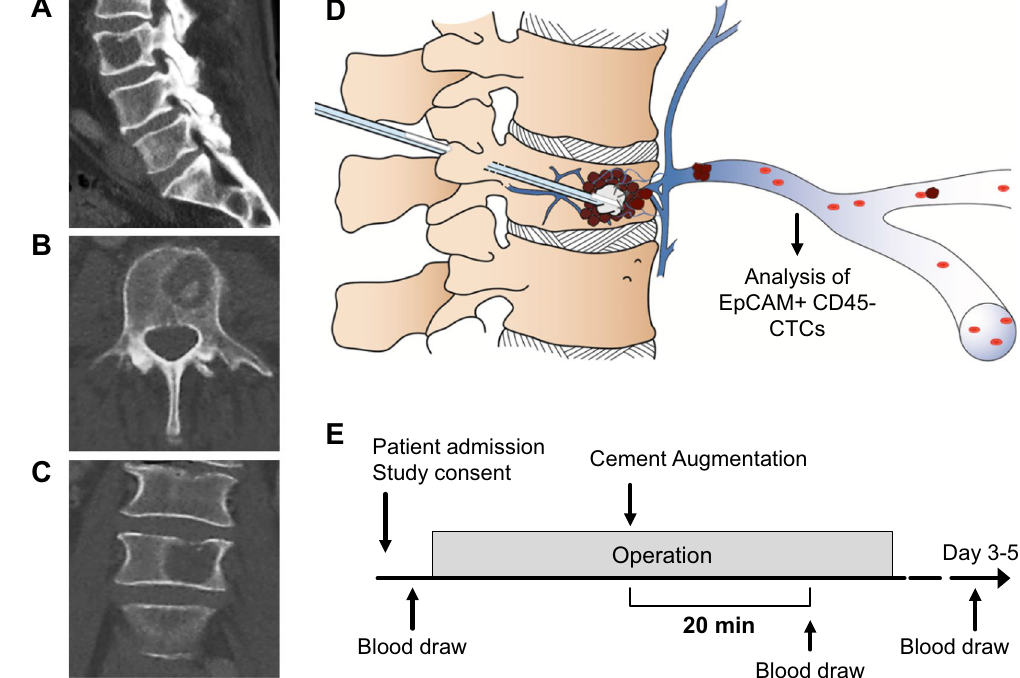
Figure 1. Study evaluating circulating tumour cells (CTCs) in cement augmentation via vertebro- (VP) and kyphoplasty (KP). ( A – D ) Radiographic X-ray image in sagittal ( A ), axial ( B ) and coronal ( C ) plane visualizing an exemplary osteolytic vertebral metastases in lumbar vertebra L3. ( D ) Schematic explanation of cement augmentation due to vertebroplasty with subsequent mechanical dissemination of CTCs. ( E ) Illustration of blood draw time-points and study design. Copyright by Sabine Wuttke, UKE,